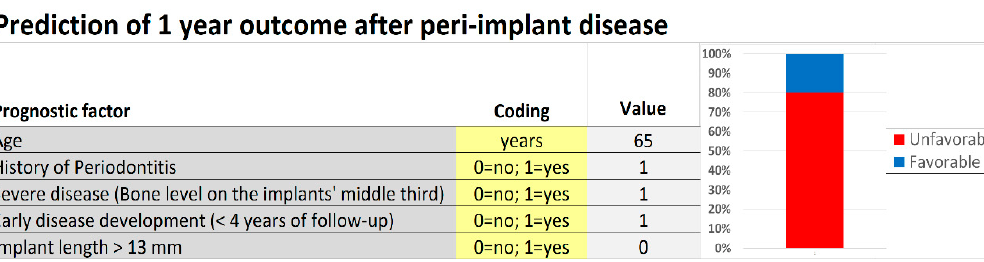
Figure 4. Evaluation periapical radiograph of implant #11 exhibiting further progression of the disease with the bone level located on the implant’s 9th thread.